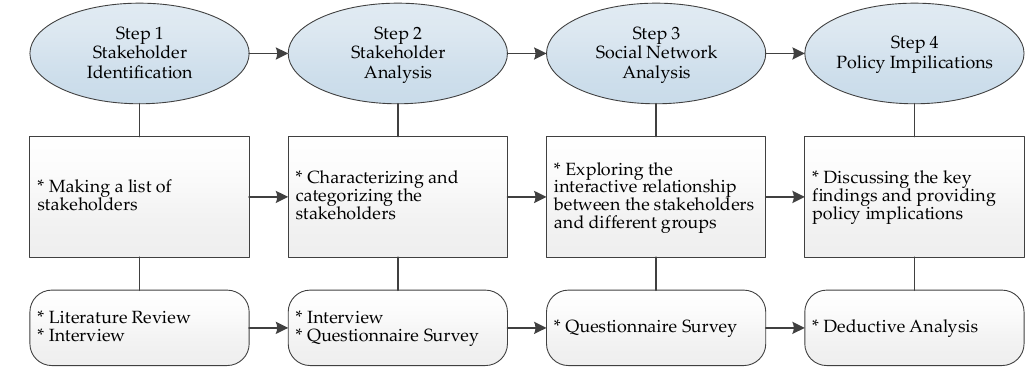
Figure 1. Research p rocess.